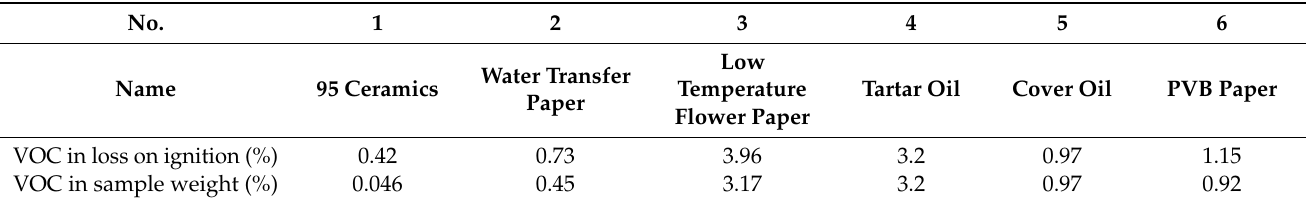
Table 6. VOC accounts for the weight proportion of flower paper, special ceramics and smoke